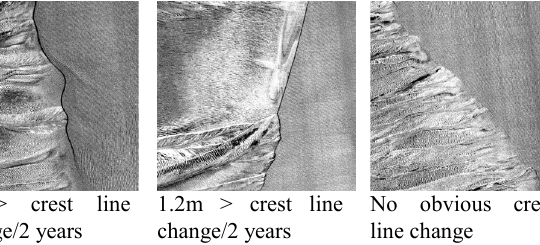
Figure 4. Estimated dune crest line change using PCA analysis, Kaiser crater